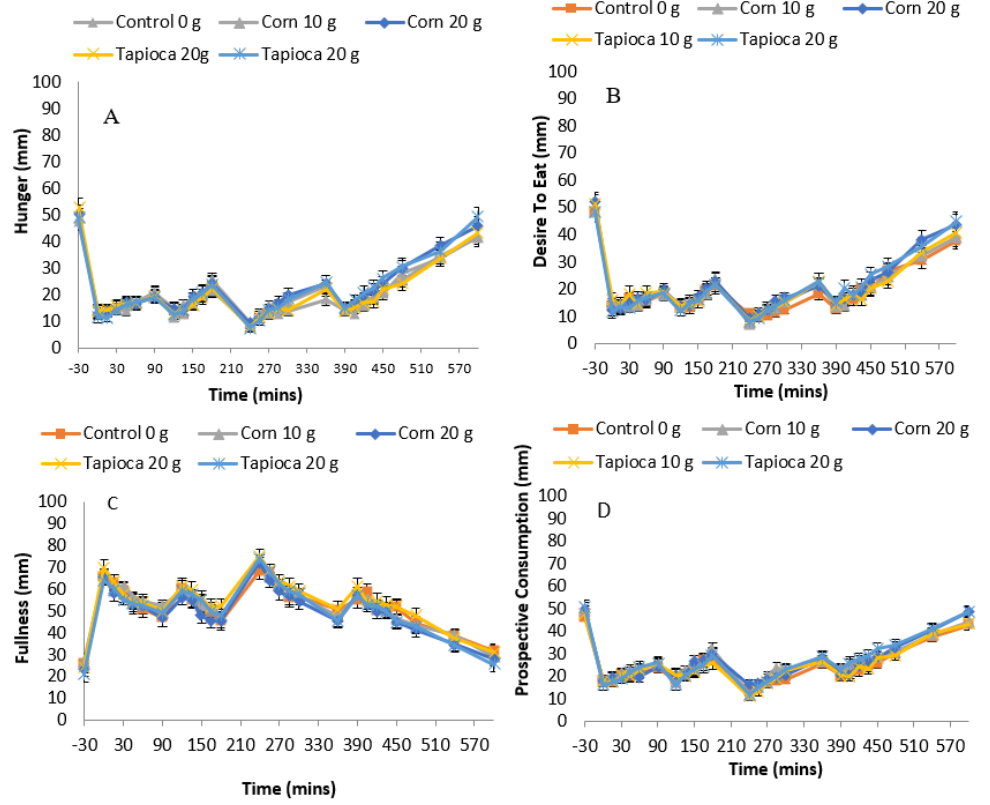
Figure 3. VAS (visual analogue scale) scores of hunger ( A ), fullness ( B ), desire to eat ( C ) and prospective consumption ( D ) rated from baseline through 600 min following control (triangles), Corn10 (diamonds), Corn20 (circles), Tapioca10 (star) and Tapioca20 (square) treatments. There were no statistically significant treatment di ff erences observed ( p > 0.